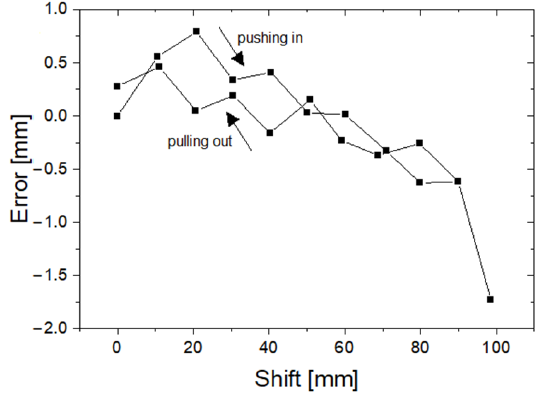
Figure 12. Hysteresis in the measuring system of the D1 device.